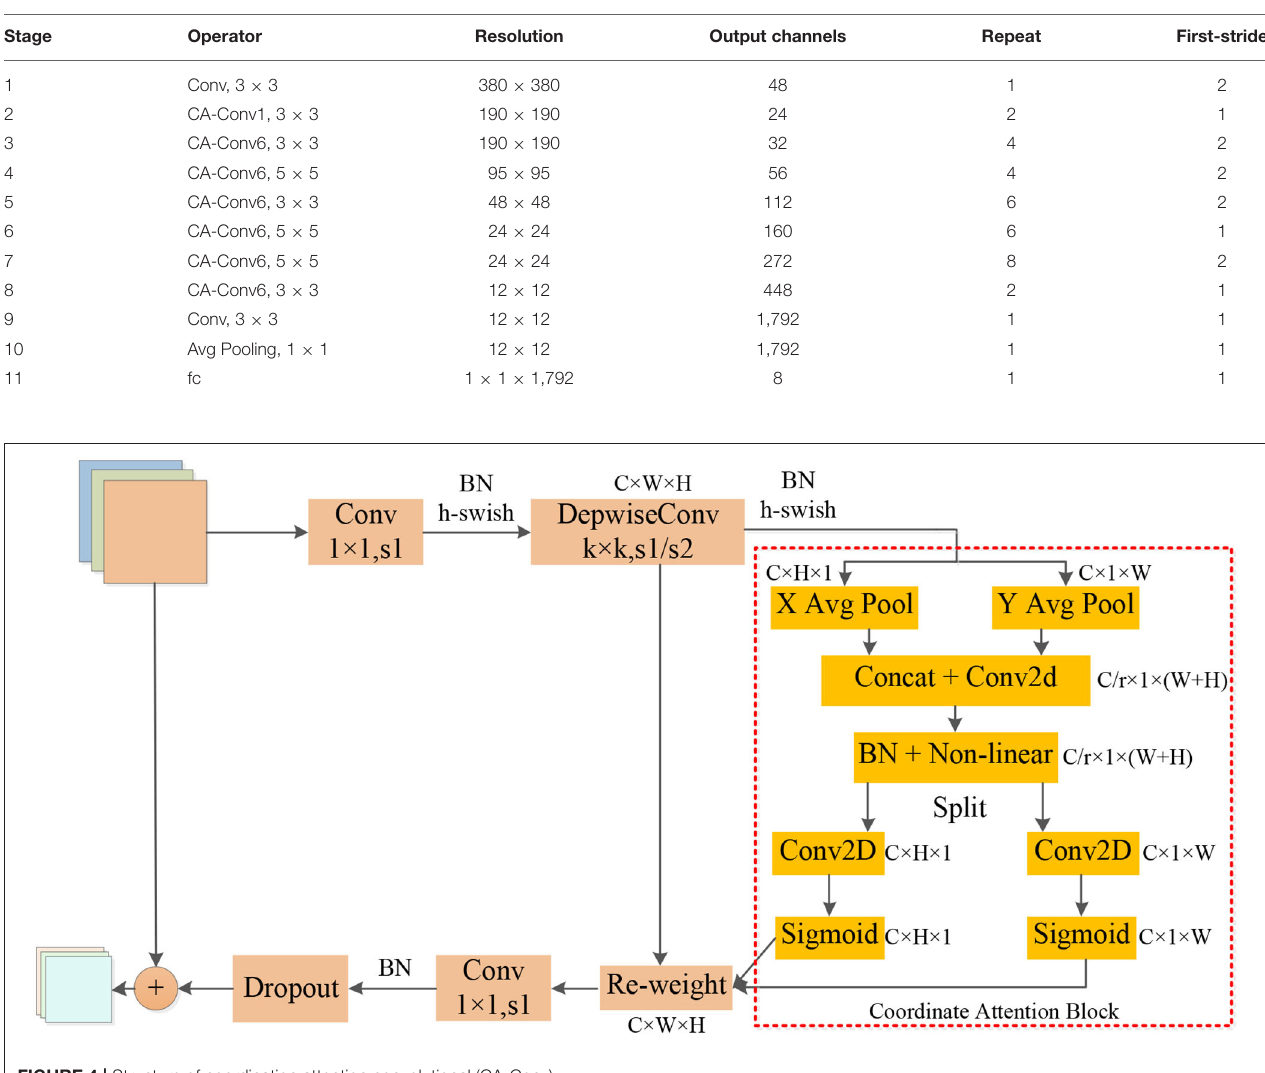
TABLE 2 | Details about coordination attention EfficientNet (CA-ENet).